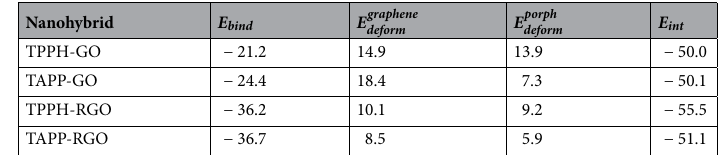
Table 2. Binding energy ( E bind ) released upon nanohybrid formation and its decomposition according to the scheme presented in Fig. 6. All values are in kcal mol